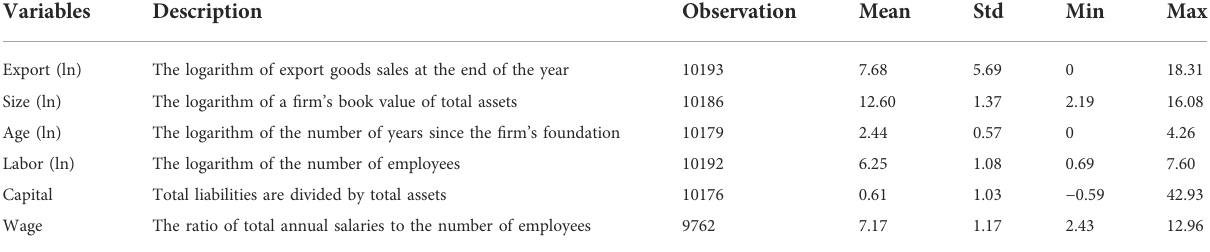
TABLE 1 Variable de fi nitions and statistics.